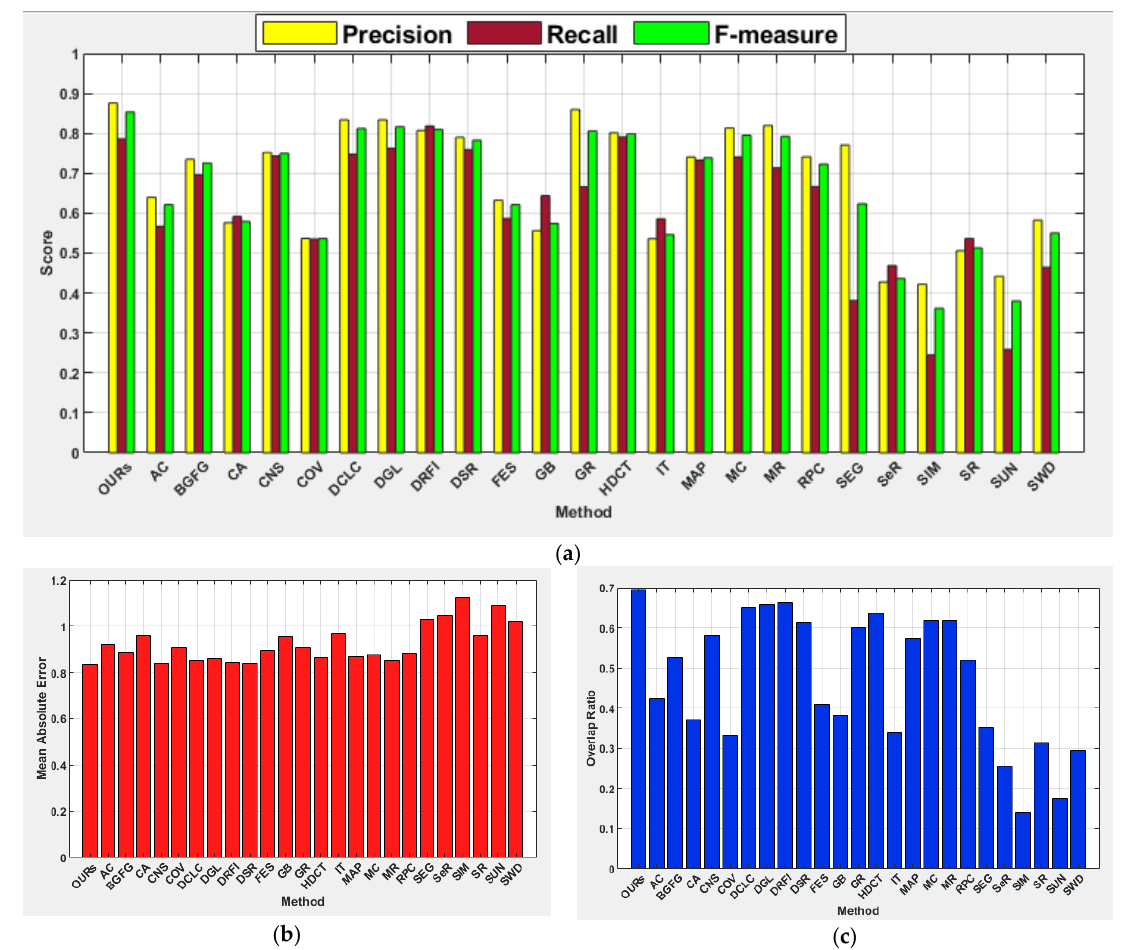
Figure 9. ( a ) F-measure; ( b ) MAE and ( c ) OR on image category: Multiple salient objects.